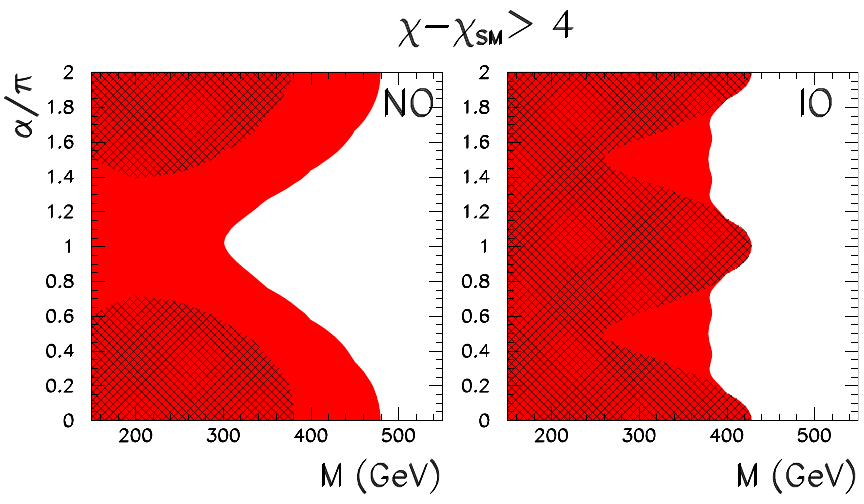
Figure 6 . 95% excluded triplet mass in the MLFV Type-III see-saw scenario as a function of the unknown phase (cid:11) from the analysis of pp ! ll 0 jj(cid:23)(cid:23) events with l; l 0 being either e or (cid:22) of either charge observed in the LHC Run-I in ATLAS [22]. The full regions correspond to the likelihood function constructed including the full information given on (cid:13)avour and charge of the (cid:12)nal states (see eq. (4.1)) while the hatched ones are obtained from the analysis of the total data summing over charge and (cid:13)avour (see eq. (4.2)). The triplet couplings have been marginalized within the ranges allowed at 95% CL by the neutrino oscillation data analysis in ref. [35] for NO (left) and IO